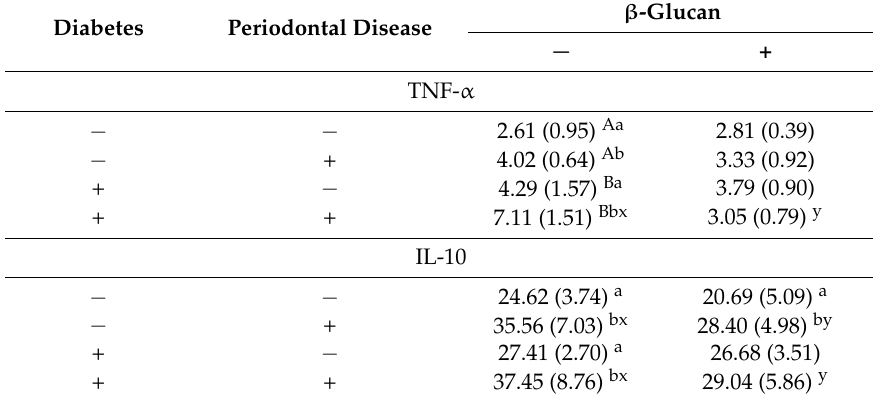
Table 3). Treatment with β -glucans reduced the TNF- α blood levels in diabetic animals with periodontal disease and IL-10 levels in diabetic and nondiabetic animals with periodontal disease ( p < 0.05; Table 3). Table 3. Concentration of TNF- α and IL-10 (pg/mL; mean ± standard deviation) of animals with diabetes and/or periodontal disease treated or not treated with β -glucan at a dose of 30 mg/kg/day for 28